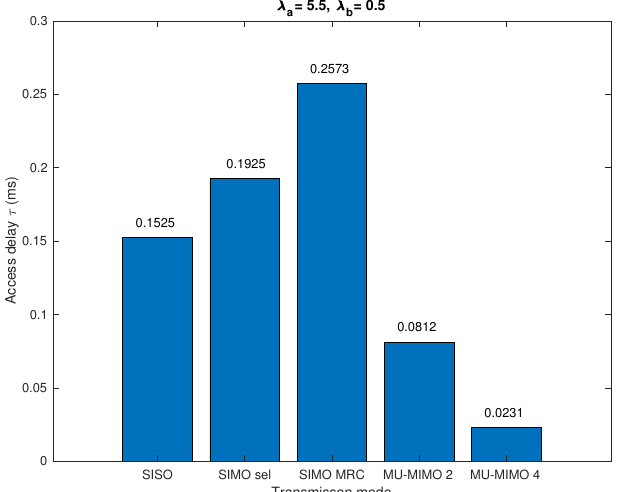
Figure 8. Low access delay τ with statistical dimensioning in which the maximal delay τ max = 1 ms, λ a = 5.5 nodes/km 2 and λ b = 0.5 nodes/km 2